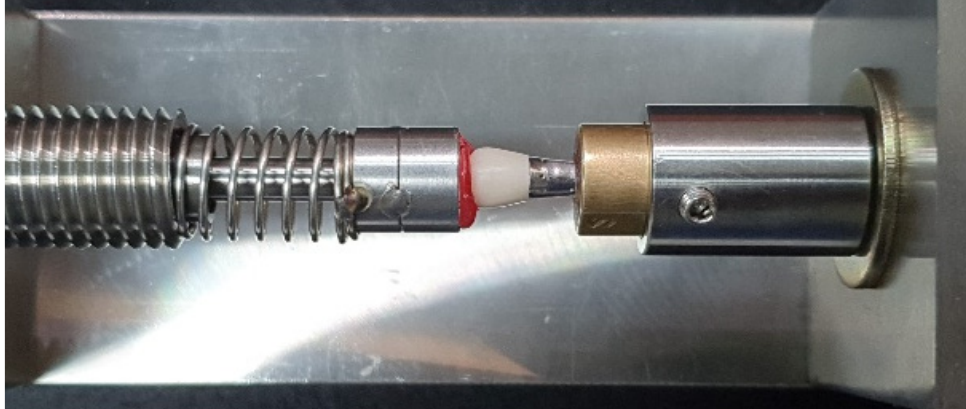
Figure 3. Marginal fit evaluation device with a crown fitted on the metal die.